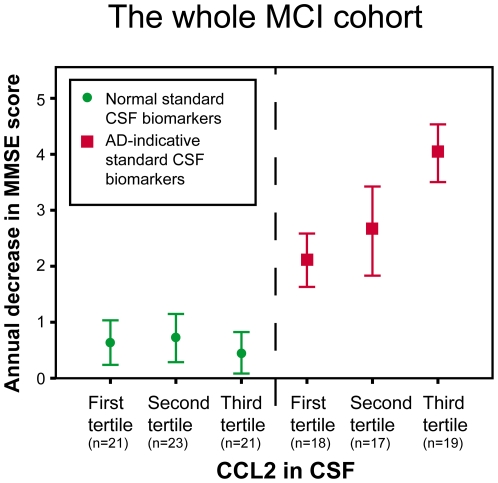
The clinical value of combining baseline levels of CSF CCL2 with standards CSF biomarkers (i.e. Tau, P-tau and Aβ42) in the whole MCI cohort.MCI patients with an AD-indicative CSF biomarker pattern (Tau>350 pg/ml and Aβ42/P-tau ratio <6.5; red squares) declined cognitively during follow-up, because many of these patients developed AD dementia, which was not the case for those with a normal CSF biomarker pattern (green circles). Importantly, the disease progression rate was significantly higher in MCI patients with an AD-indicative CSF biomarker pattern, who also had high CCL2 levels (in the third tertile) when compared to those who exhibited lower levels (in the first tertile) (p<0.05).